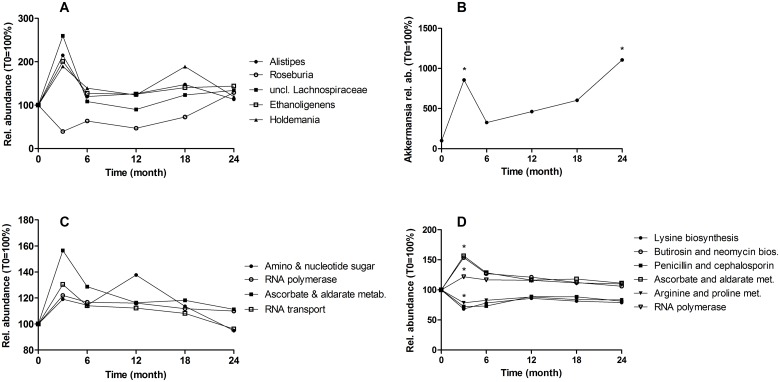
Abundance change of genera and metabolic pathways during the study.A. Relative abundance of five genera, which were the most abundant among those that changed during time. B. Akkermansia abundance. C. Relative abundance of all KEGG pathways that changed during whole study. D. Metabolic pathways that changed from baseline to T3. Abbreviations: bios, biosynthesis; met, metabolism. Statistics: Relative abundances are expressed in percent (abundance at T0 is 100%). Each dot is the mean at a given time point. Relative abundances at different time points were compared using the Friedman test (A, C: over the six time points), or the Wilcoxon test (B, D, *p < 0.05: between baseline and T3 or T24).